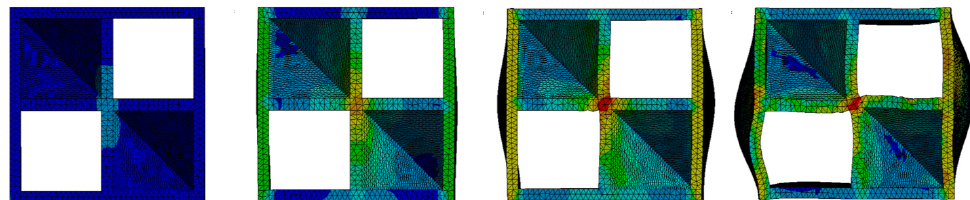
Figure 13. FE analysis of deformation process for the novel cell under lateral load.